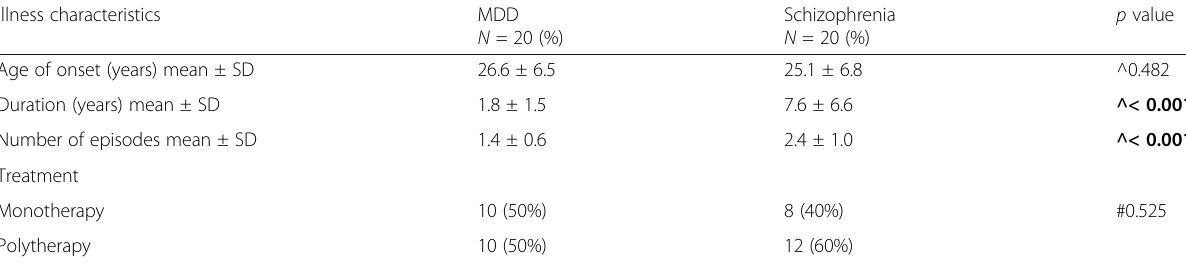
Table 1 Clinical characteristics among patients ’ groups Illness characteristics